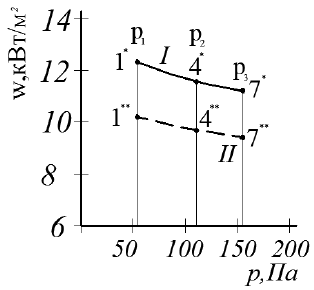
Fig. 3. Dependences of the specific power of the discharge w on the pressure of the gas mixture at interdependent BATR modes: I – modes 1*, 4* and 7*; II – also when changing the shape of the suspension (modes 1**, 4** and 7**)